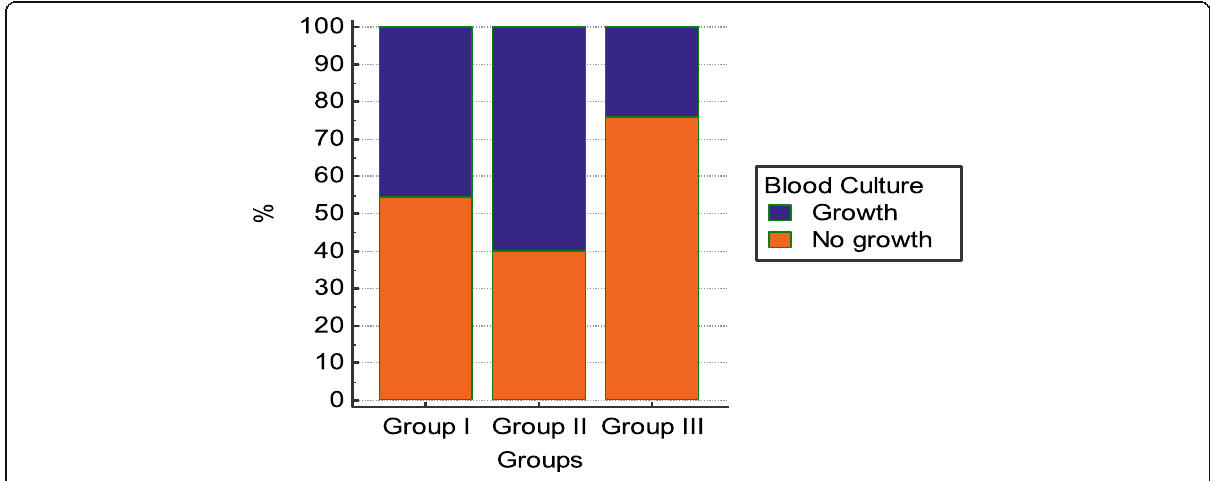
Fig. 1 Stacked bar chart showing blood culture among different studied